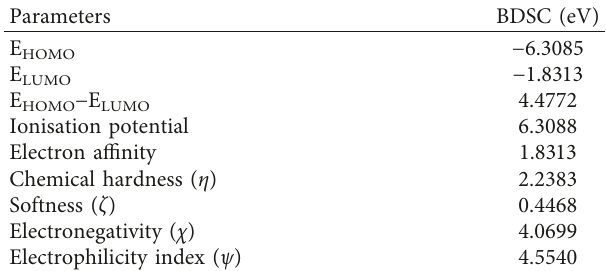
Figure 16: Frontier molecular orbitals of BDSC. Table 8: Calculated molecular orbital parameters of BDSC employing 6-31 +G (d) basis set.